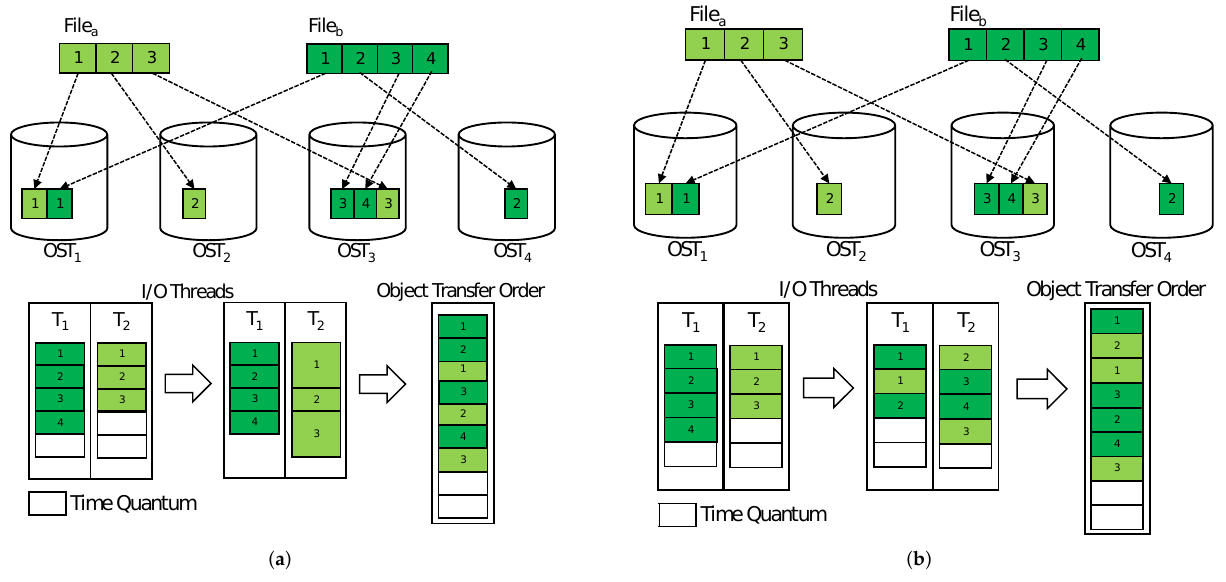
Figure 1. Illustration of OST contention in file and object-based transfer systems. ( a ) File-based transfer system. ( b ) Object-based transfer